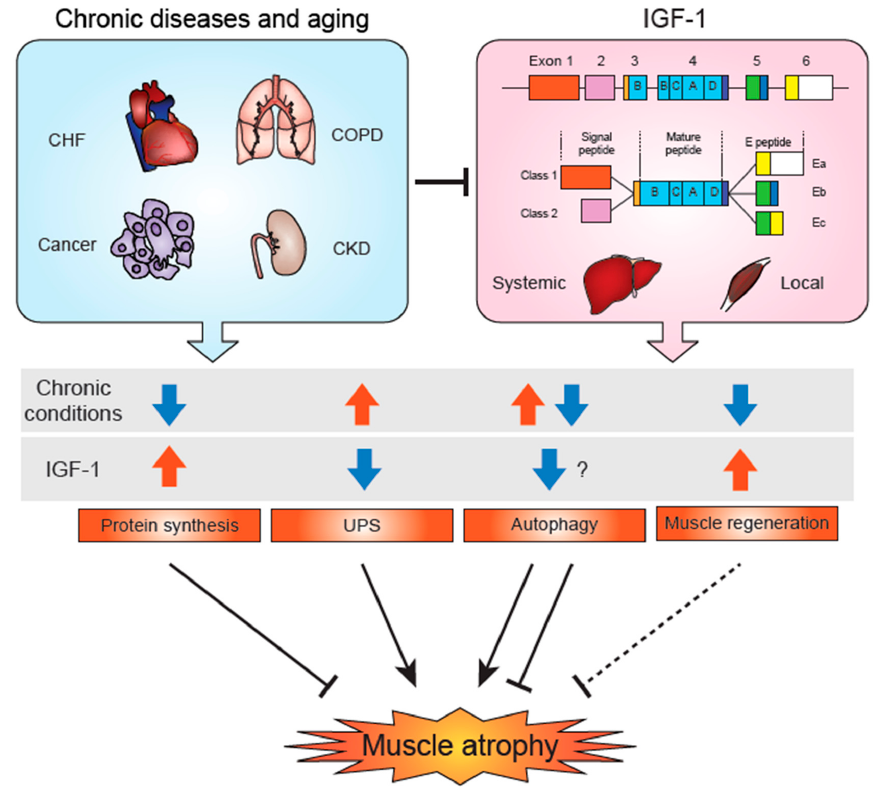
Figure 2. IGF-1 and skeletal muscle atrophy in chronic diseases and aging. In various chronic disease conditions, such as congestive heart failure (CHF), cancer, chronic obstructive pulmonary disease (COPD), and chronic kidney disease (CKD), and aging, muscle atrophy develops through various mechanisms: decreased protein synthesis, increased UPS, and lowered muscle regeneration.